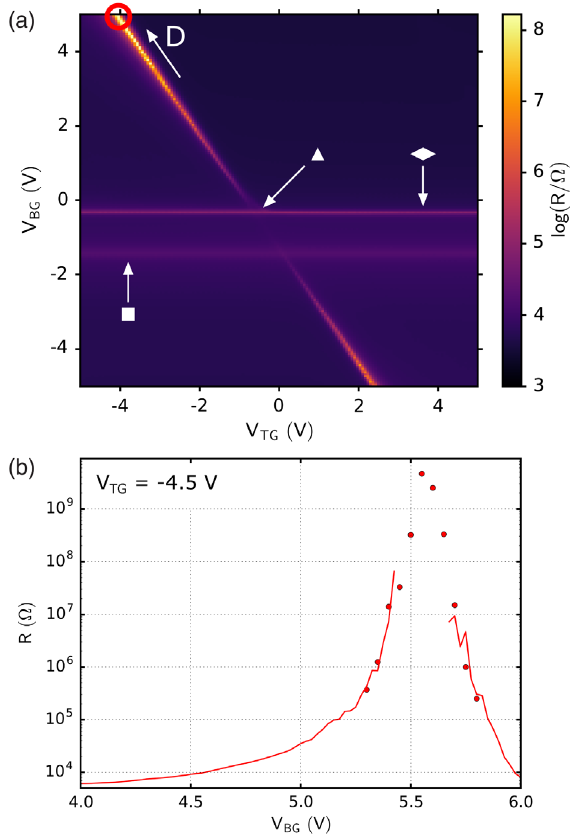
FIG. 5. (a) Logarithmic two-terminal resistance of the device as a function of the graphite back gate voltage V and the top gate BG voltage V [asterisk in Fig. 1(a)]. (b) Two-terminal resistance as TG a function of the graphite back gate voltage at fixed top gate ¼ − 4 . 5 V. The solid line was measured in a constant voltage V TG source-drain bias setup, while the circles correspond to resistance values extracted from IV characteristics recorded at the given gate voltage